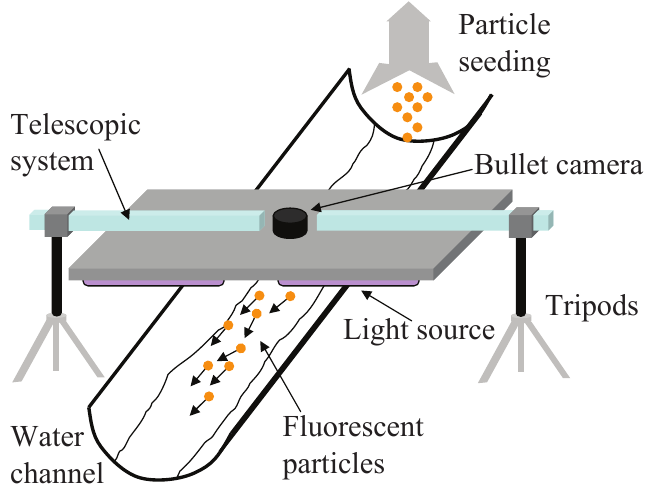
particlesWater channel